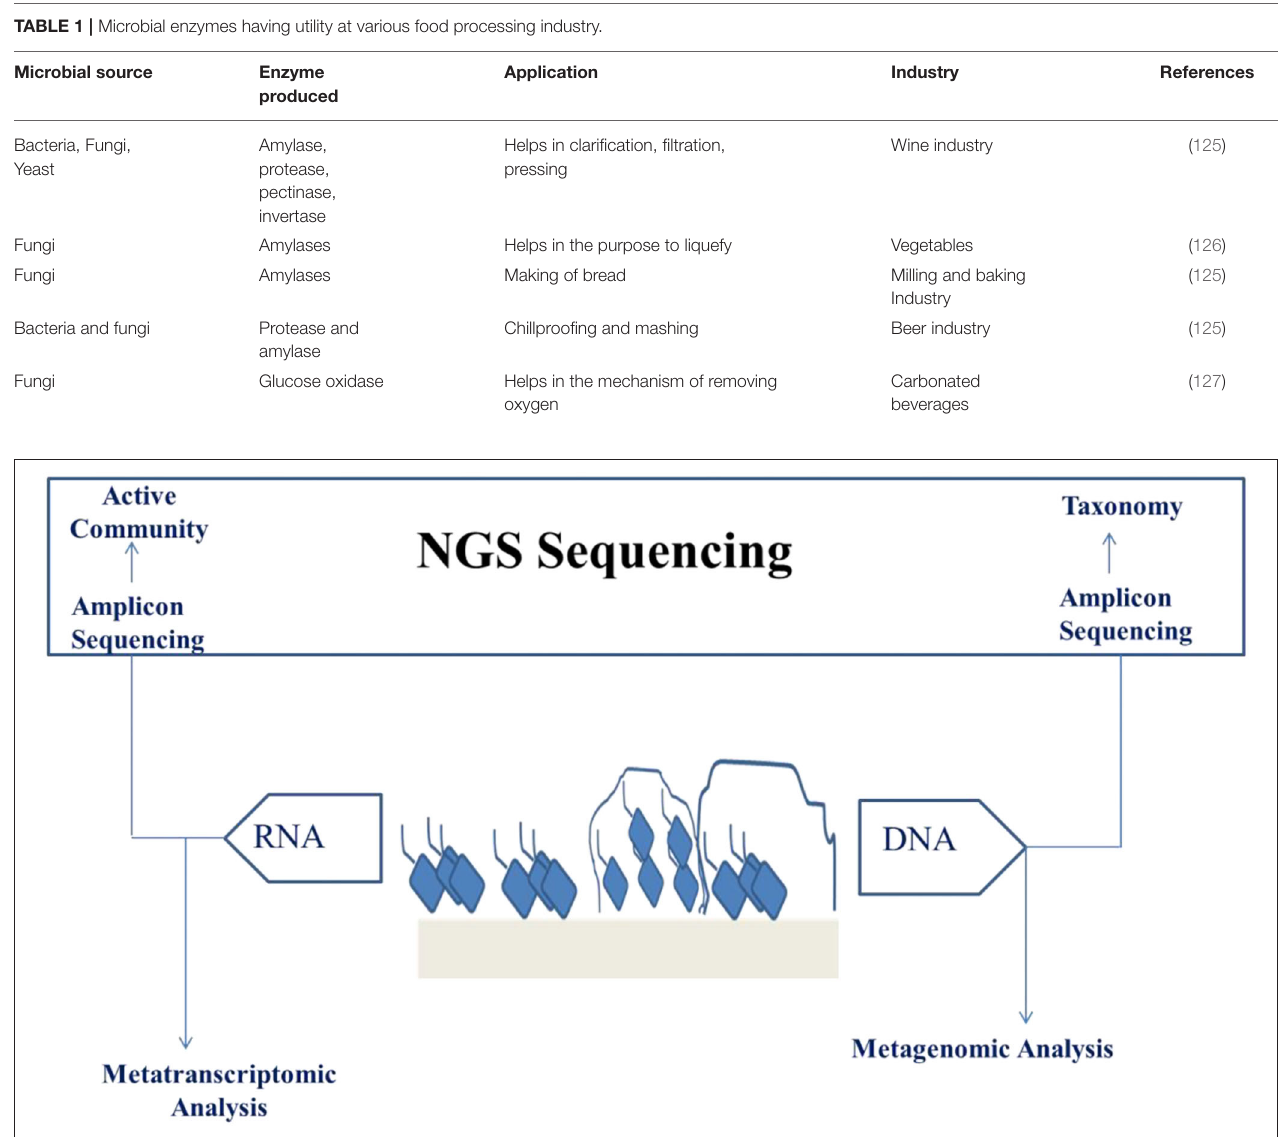
FIGURE 3 | NGS analysis of biofilm for the purpose of validating engineered food.